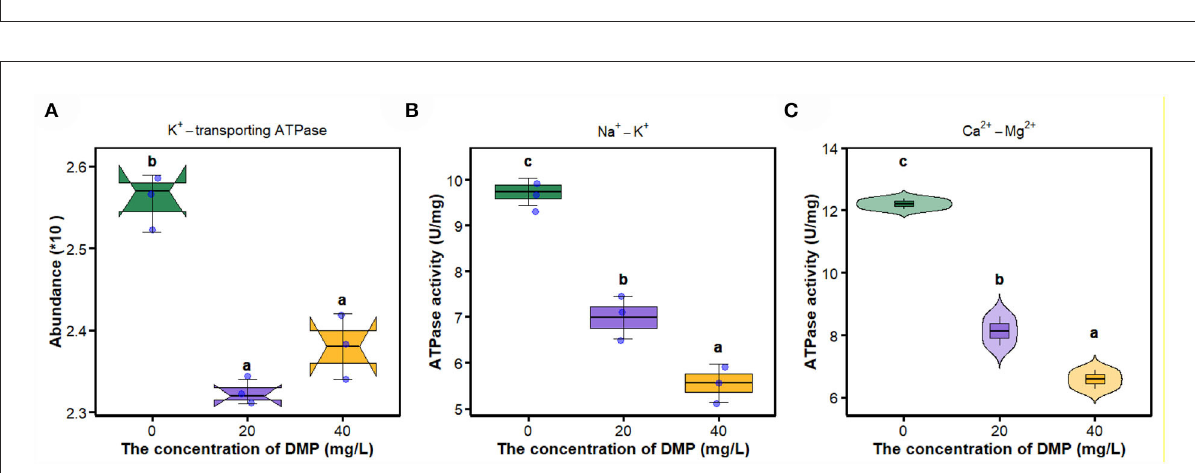
FIGURE5 The effect of DMP on key enzymes on the cell membrane of the P. fluorescens . (A) indicates that DMP inhibited the expression of K + -transporting ATPase abundance through proteomics; (B,C) indicate that the activities of Na + -K + -ATPase and Ca 2 + -Mg 2 + -ATPase of P. fluorescens were changed by DMP treatment. Different letters represent significant differences between treatments.